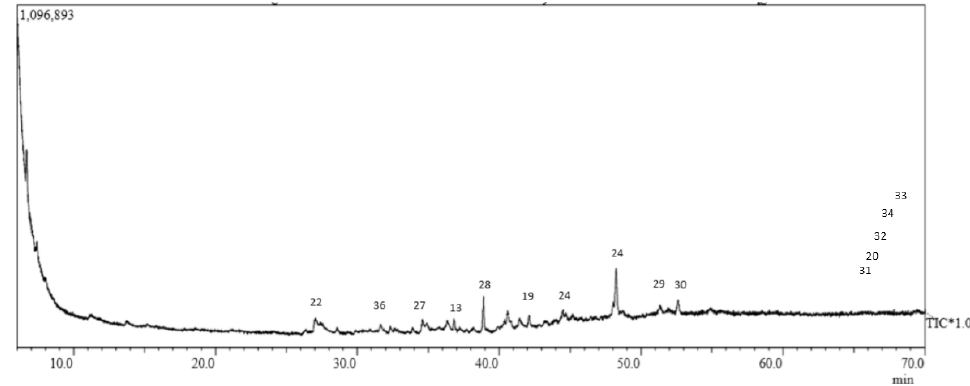
Figure 4. GC-MS Total Ion Chromatogram of callus maintained in 4°C with alginate